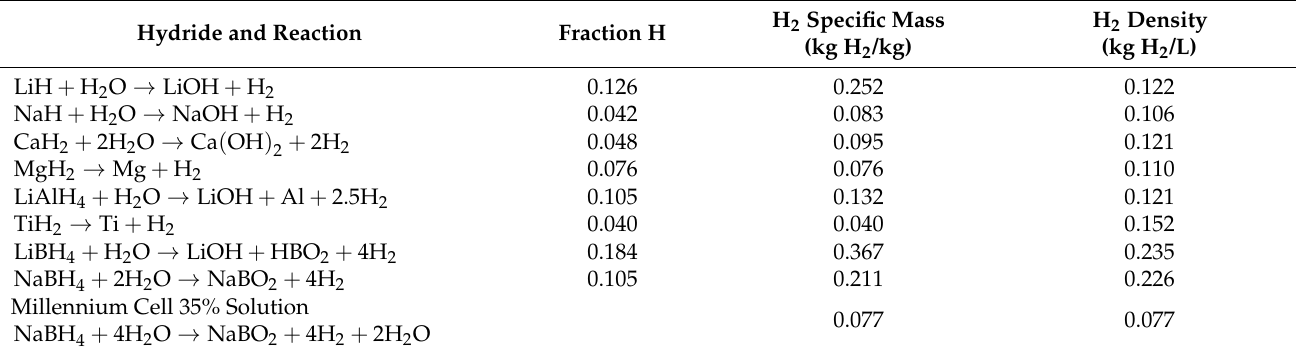
Table 1. Candidate hydride reactions and hydrogen storage properties [7].